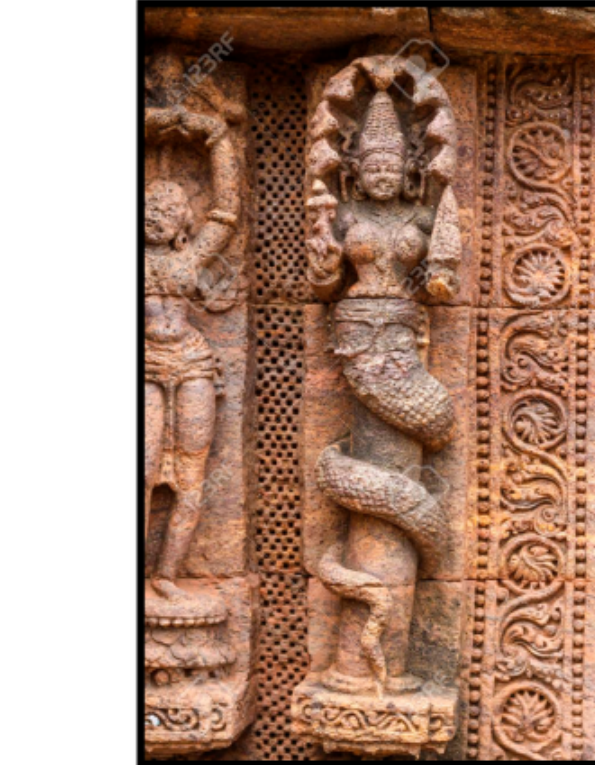
Figure 15. Naga and nagini (detail), Descent of the Ganges , stone relief, total length 25.5 m./height 12 m., Mahabalipuram, Pallava dynasty, Tamil Nadu, 7th century.